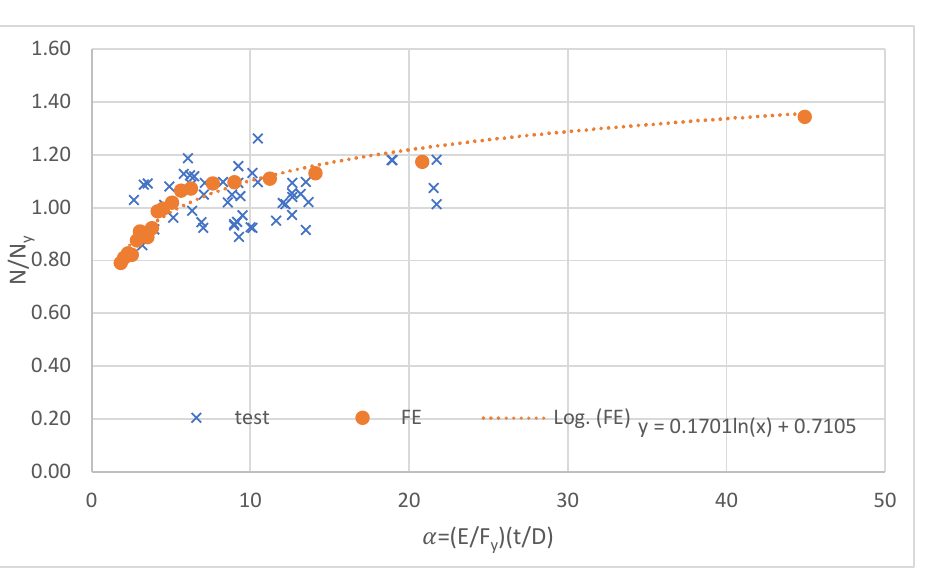
Figure 14. The relation between normalized axial compression and non-dimensional buckling parameter ( α ) of experimental results by others and FE by authors for HSS-S460.